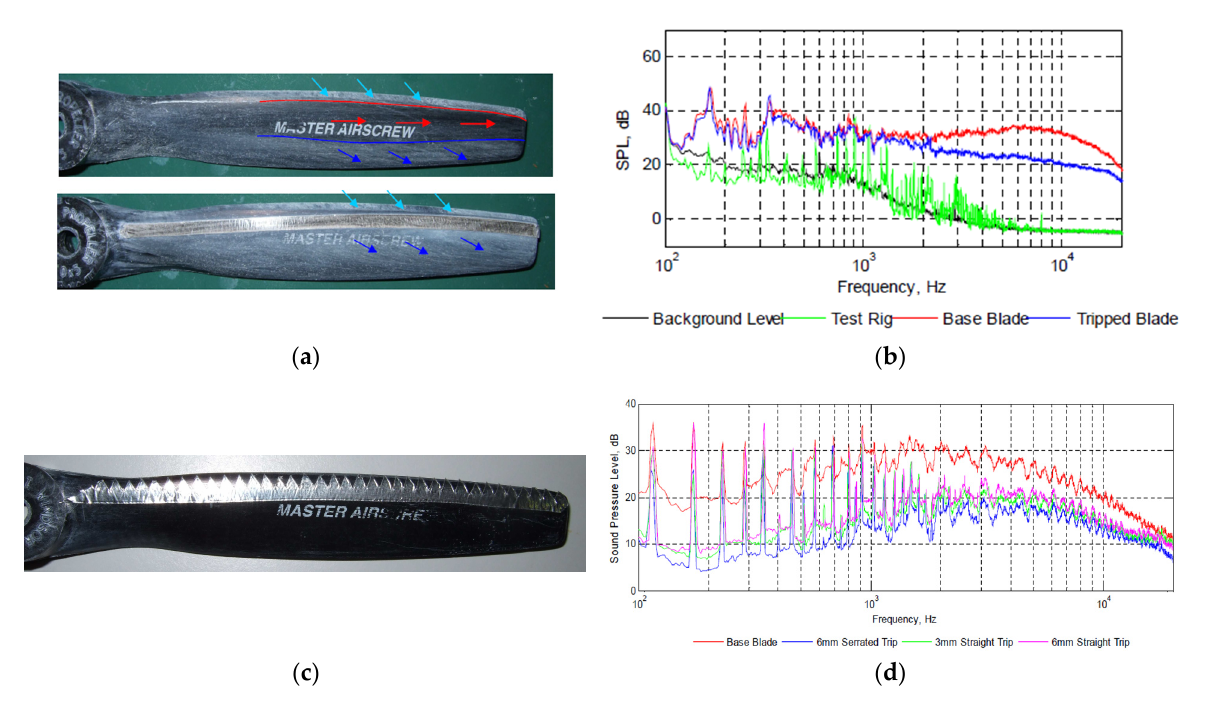
Figure 2. Effects of LE trip and serration as a passive noise control technique [16]. ( a ) Base propeller (top) and leading-edge tripped propeller (bottom). ( b ) Spectra showing effect of LE trip in Wind tunnel tests (V = 10 m/s, 5000 RPM). ( c ) Schematic of propeller showing Leading-edge serrations. ( d ) Spectra showing effects of various serration depths. Reprinted with permission from Wong, K.C. (2008).